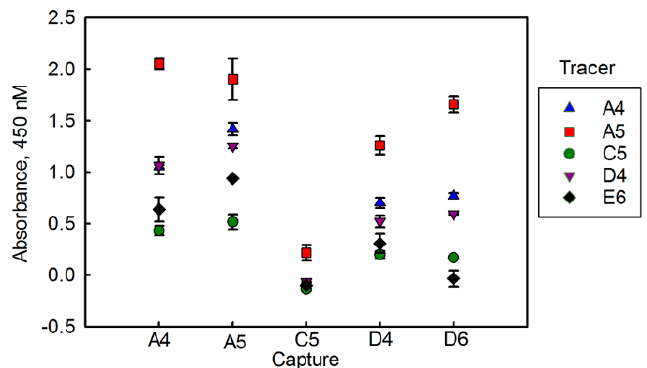
Figure 2. Checkerboard-enzyme linked immunosorbent assay (ELISA) to determine the optimal capture and tracer pairs. Each of the five sdAb captures are shown on the X axis and tracers indicated by the symbol (key to the right of the graph). Each tracer sdAb was biotinylated, while the capture sdAbs were adsorbed on the ELISA plate. Measurements were performed in duplicate. The average background (0.41) was subtracted from the average values; error bars represent the average deviation.